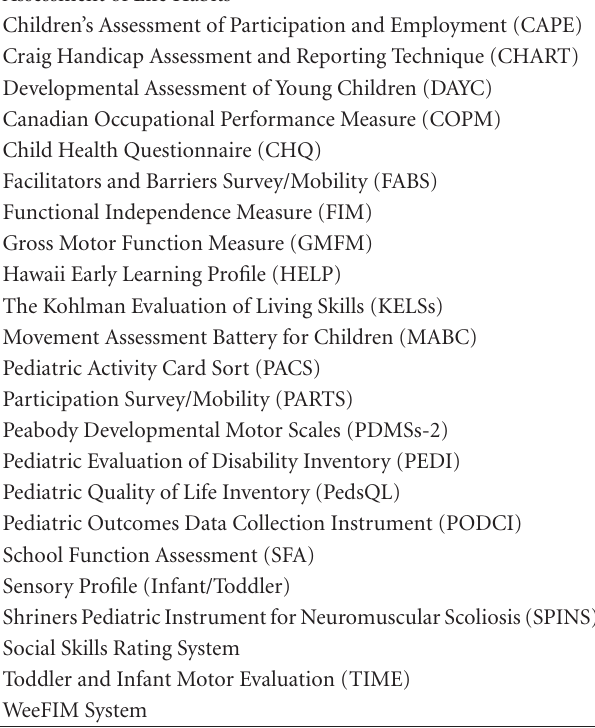
Figure 1: Item development. Table 1: Assessment